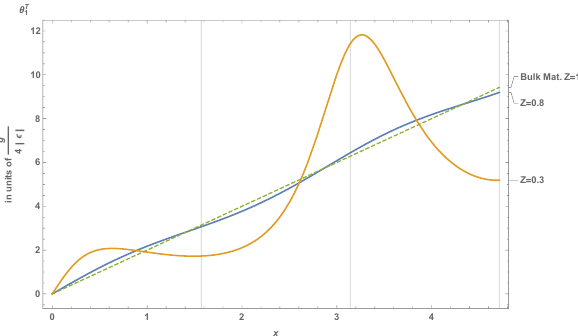
Figure 1: Faraday Rotation angle θ T 1 as a function of x = ωnL / c for Z = 0.3 and Z = 0.8 (colour